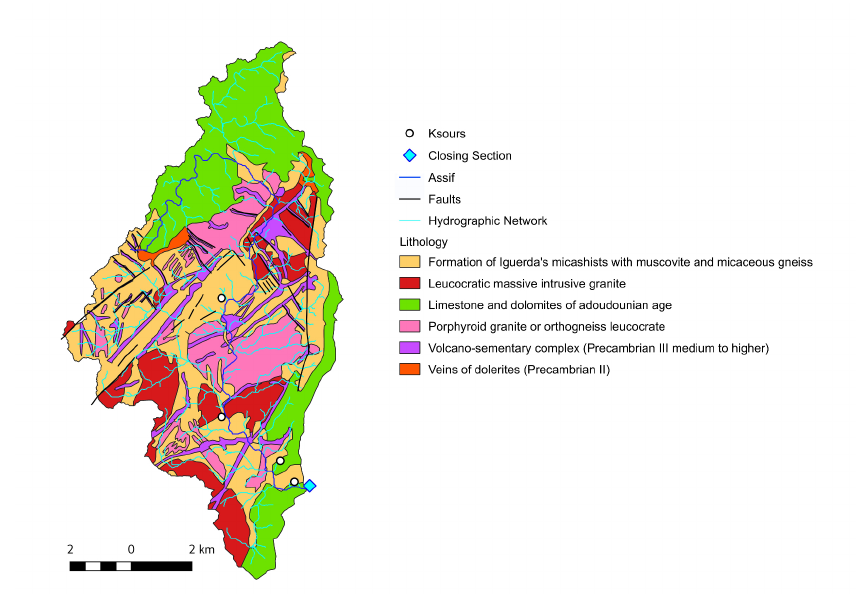
Figure 10. Geological map of the Assaragh watershed extracted from the geological map of